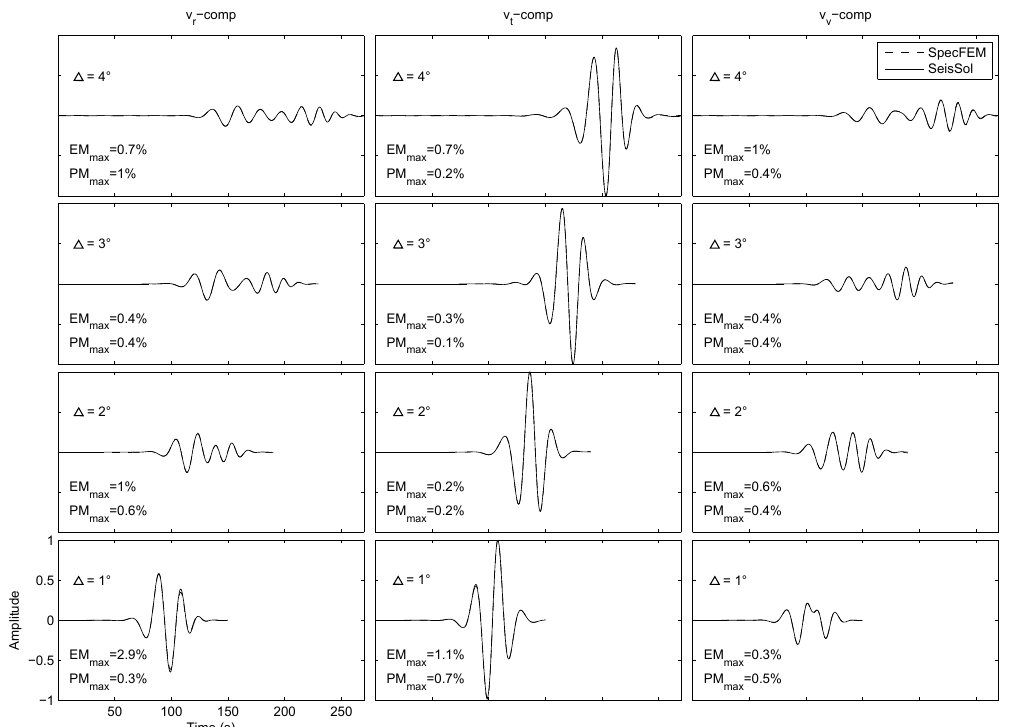
Fig. 3. Synthetic seismograms obtained on the 1-D isotropic PREM model by the ADER-DG (solid) and the spectral-element method (dashed) compared at epicentral distances 1 for a real source located in the Norwegian Sea. The data are convolved with a Ricker source time function and filtered to periods of T ≥ 20s. Amplitudes of the radial v r , transverse v t and vertical v v velocity component are normalized with respect to v t . The fit between the different synthetic results is quantified by the phase (PM) and envelope (EM) time-frequency misfits. Artificial boundary reflections are